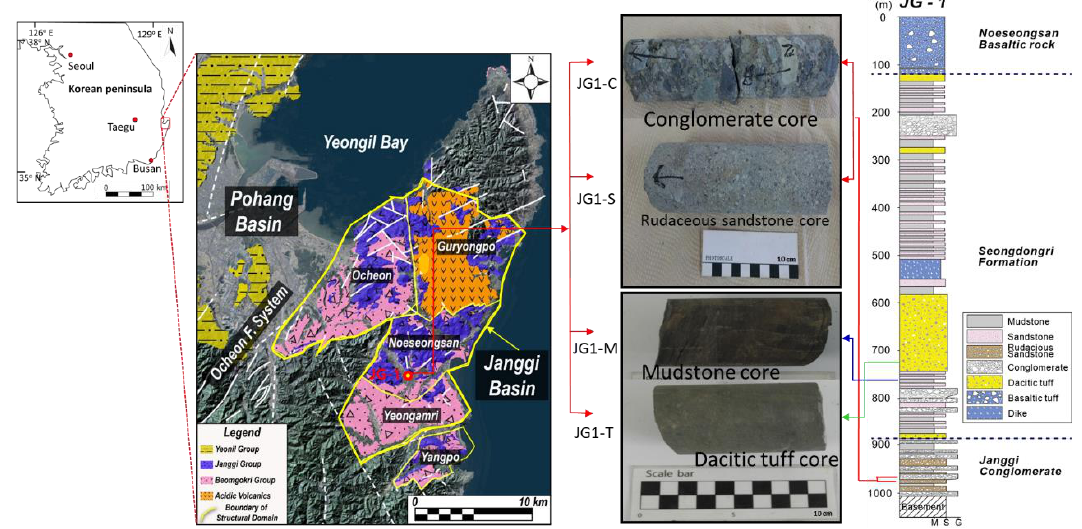
Figure 1. Geological map of the area around the drilling site (JG-1: ) in the Janggi Basin, Korea, photographs of rock cores used for the experiment and the stratigraphic columnar section (from left to right) used for the experiment (modified from [7,8]).